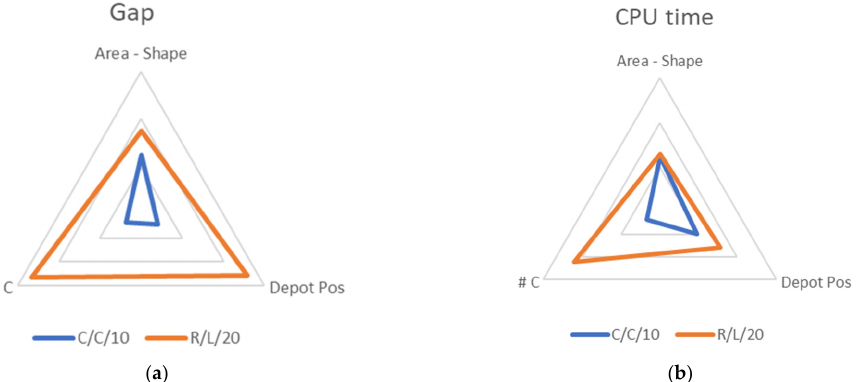
Figure 4. Factors influencing the model behavior: ( a ) impact on the optimality gap; ( b ) impact on computational time.